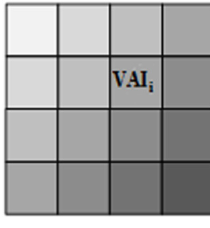
Figure 1. Schematic representation of spatial heterogeneity of Vegetation Area Index (VAI) in a pixel.